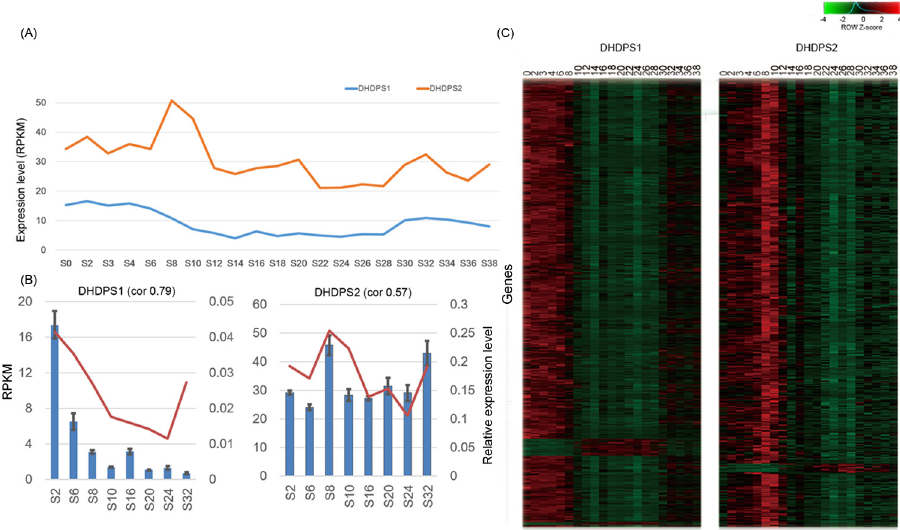
Fig 4. Expression patterns of dihydrodipicolinate synthase (DHDPS) genes. (A) Expression levels reads per kilobase per million reads (RPKM) of DHDPS genes in 21 maize developmental stages. (B) Quantitative real-time PCR (qRT-PCR) validation of RNA-Seq-based DHDPS expression levels. qRT-PCR expression profiles (blue bars) of DHDPS genes closely match the RNA-Seq data (red lines). The correlation value (cor) was calculated using Pearson ’ s correlation coefficient. The error bars in the figure represent the standard deviation. (C) Heat map of expression profiles of DHDPS-coexpressed genes (Y axes). Numbers next to the heat map represent the number of days after pollination. (The error bars represent standard deviation).